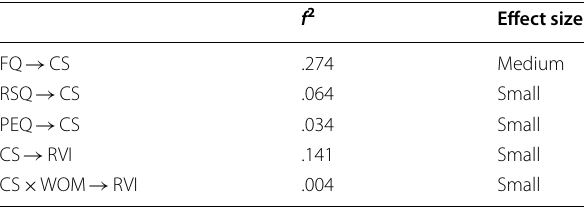
Table 6 Results of f square